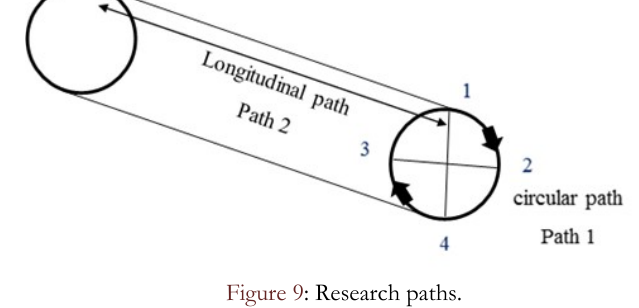
Figure 9: Research paths.